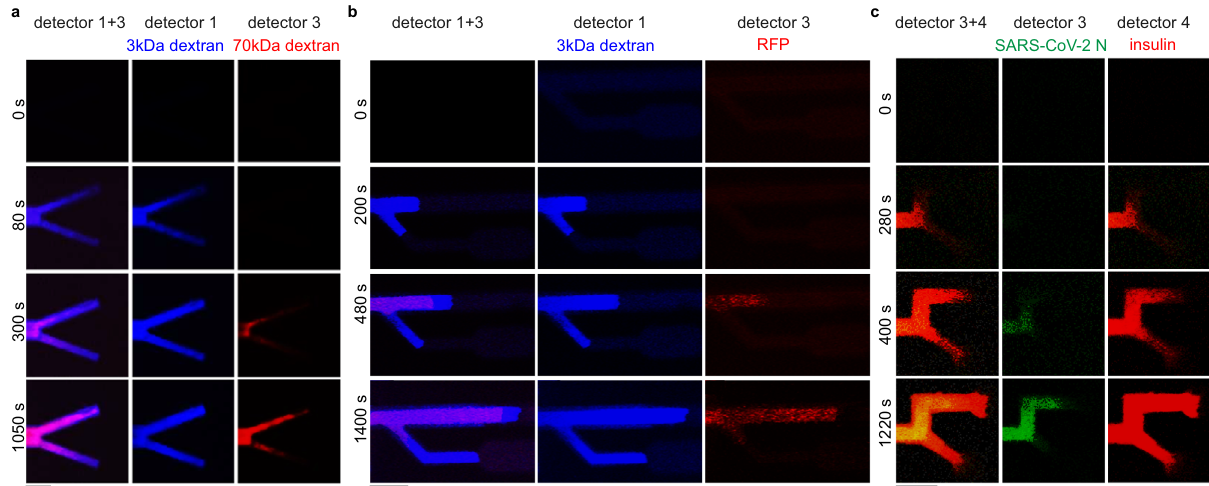
Fig. 6 Biomolecular separations by OM microchannels. Imaging was conducted by an inverted confocal laser scanning microscope (CLSM, Nikon A1R). a Separation of two polysaccharides of different molecular weights, where the blue and red colours represent 3-kDa (Cascade Blue labelled) and 70-kDa (Texas Red labelled) fl uorescent dextran, respectively. b Separation of polysaccharide from protein, where the blue and red colours represent a fl uorescent dextran (3 kDa) and a red fl uorescent protein (RFP, 27 kDa), respectively. c Separation of two proteins of different molecular weight, where the green and red colours represent SARS-CoV-2 nucleocapsid protein (55 kDa, pre-stained with the dye SYPRO Orange) and fl uorescent insulin (Alexa Fluor 680 labelled, 6 kDa), respectively. These OM microchannels were made on cover glass using a micro-LED instrument ( λ i = 405 nm). Microchannels were printed according to the design in Supplementary Fig. 10 with different energy dosages in the main channel and the side branch. The microscope photos of these OM channels are shown in Fig. 5c – e, respectively. Further experimental details are provided in Supplementary Table 6. Scale bar, ( a – c ), 100 μ